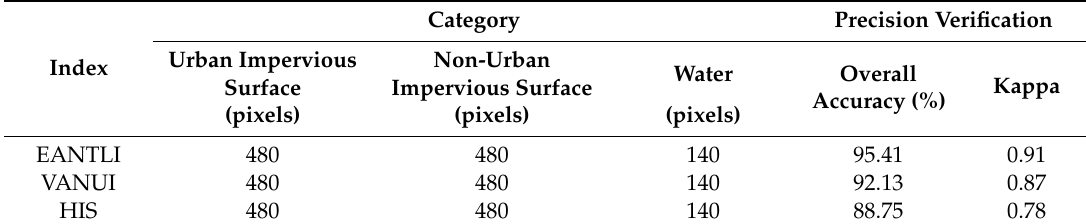
Table 2. Evaluation of classification accuracy of three index extraction results in 2013.